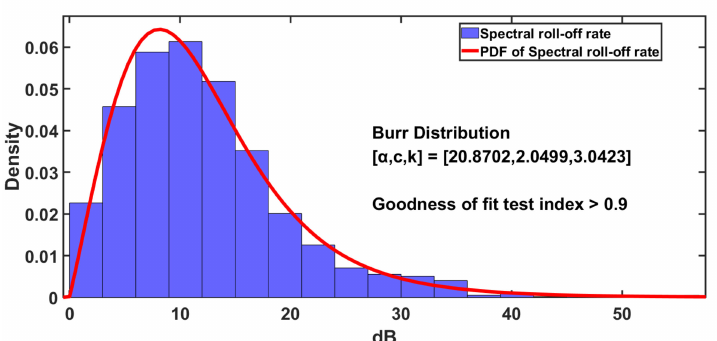
Figure 8. Distribution of the roll-off rates of the acoustic emission signals of pipelines with a leakage.